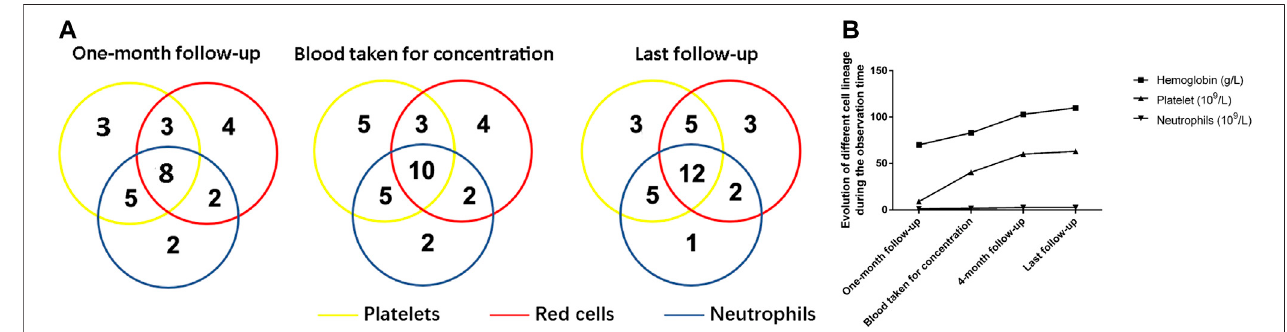
FIGURE 1 | Hematologic improvements caused by Eltrombopag at different time points. (A) The Venn diagrams show the number of patients with unilineage, bilineage, and trilineage hematologic responses at the time when the blood concentration was determined and at the time of last follow-up. (B) A cumulative line chart showing hemoglobin/platelet/neutrophil evolution during the observation time.